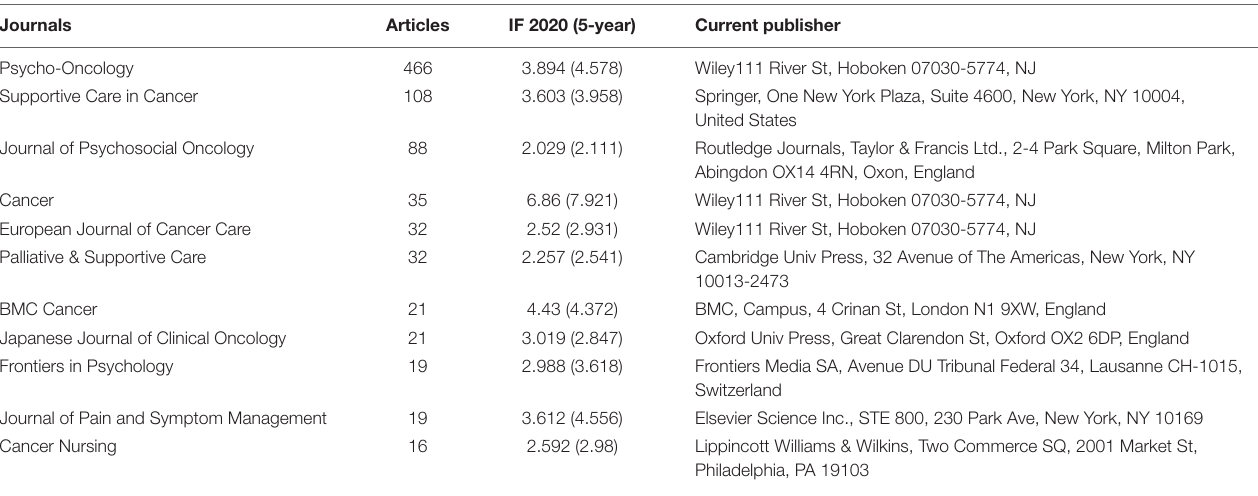
TABLE 5 | Most relevant journals in psycho-oncology research.